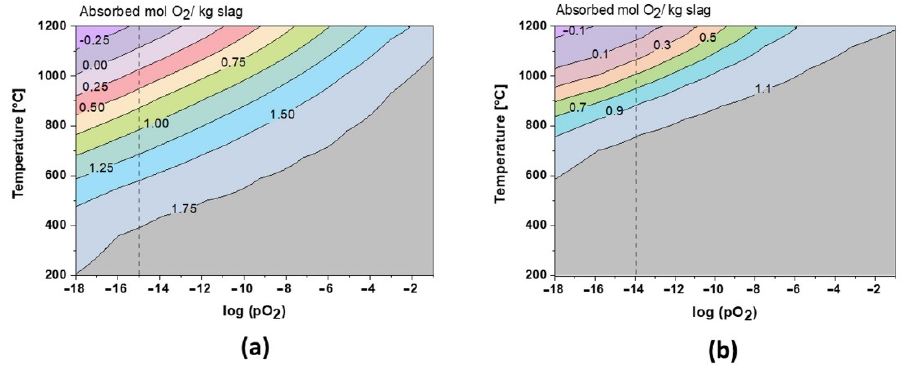
Figure 8. Theoretical O 2 absorption in slag 1 ( a ) and slag 2 ( b